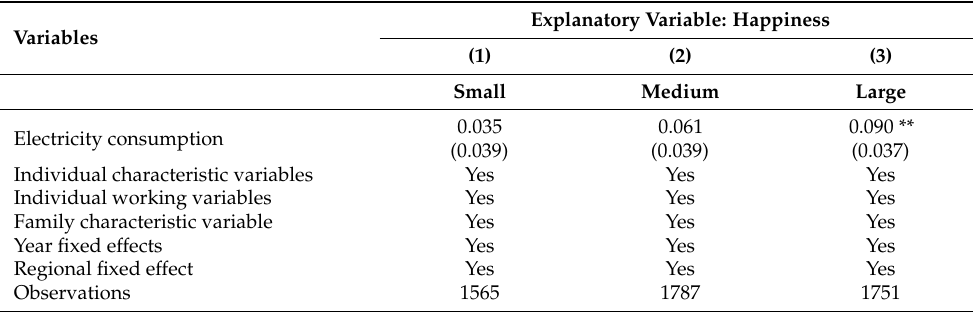
Table 9. Heterogeneity analysis from the perspectives of living